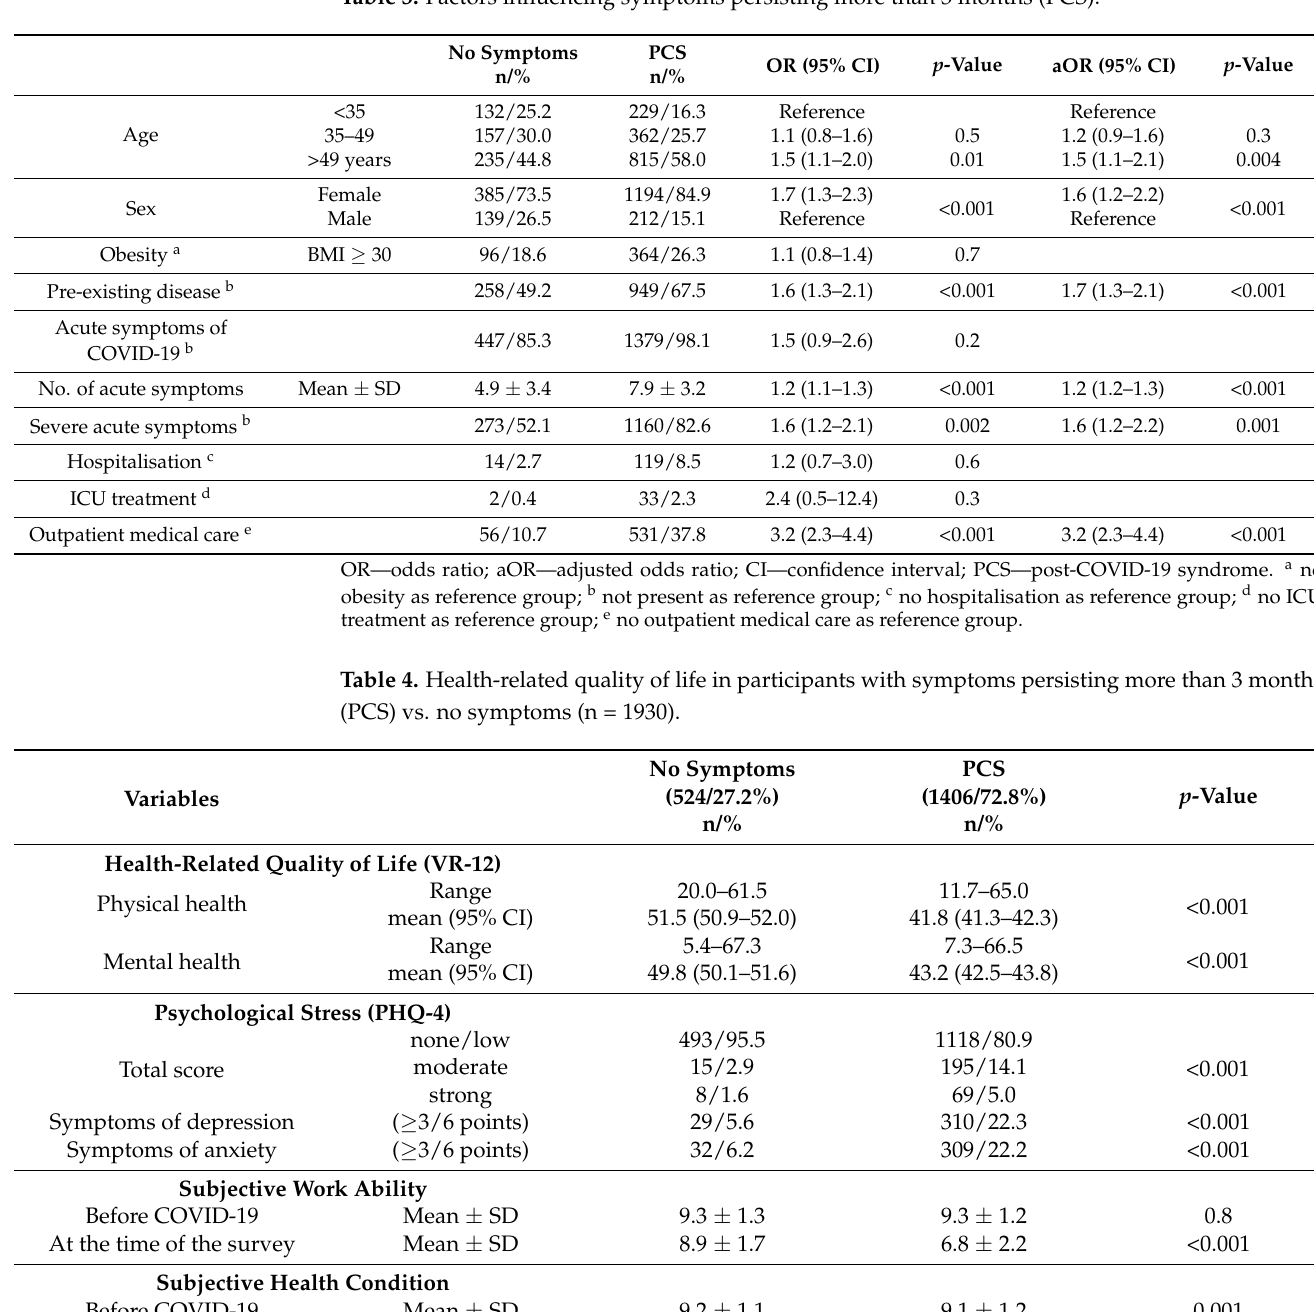
Table 3. Factors influencing symptoms persisting more than 3 months (PCS).